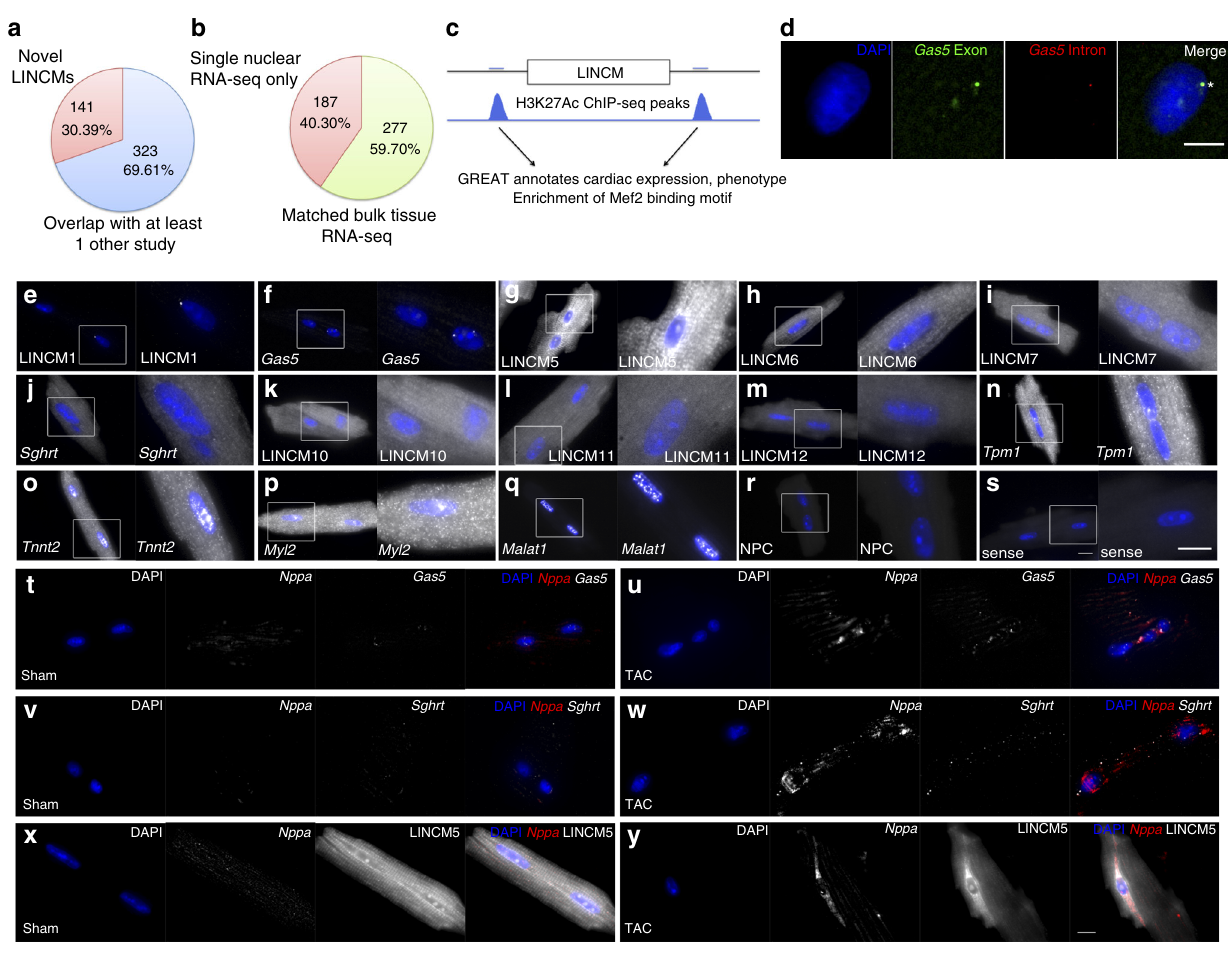
Fig. 5 LINCM expression validated by single molecule RNA FISH. a Single nuclear RNA-seq identi fi es 141 novel lincRNAs in nuclei of CMs ( LINCMs ) that are not in current public databases (ENSEMBL and NONCODE) nor published cardiac transcriptome data sets. b Single nuclear RNA-seq identi fi es LINCMs that are not detectable in matched left ventricle bulk tissue RNA-seq, explained by the dilution of reads in cytoplasmic mRNA pool. c Active H3K27Ac enhancer chromatin regions proximal to LINCMs are enriched in MEF2 transcription factor binding motif and functionally annotated by GREAT analysis to have cardiac expression and phenotypes. d Sites of active transcription demonstrated by co-localization of exonic and intronic probes ( asterisk ) in nucleus. Scale bar represents 5 μ m. e – m Single molecule RNA FISH validates the expression of LINCMs in isolated adult mouse CMs. n – q Positive controls for highly abundant core genes Tpm1 , Tnnt2 , Myl2 , and Malat1 . r , s Negative controls with no-probe control (NPC) ( r ) and sense probe ( s ) to con fi rm signal speci fi city. Scale bar represents 10 μ m. t , u Gas5 is upregulated in TAC CM and co-localizes with perinuclear Nppa transcripts. v , w Sghrt is upregulated and localizes to the cytoplasm of TAC CM. x , y LINCM5 is downregulated in TAC CM. Scale bar represents 10 μ